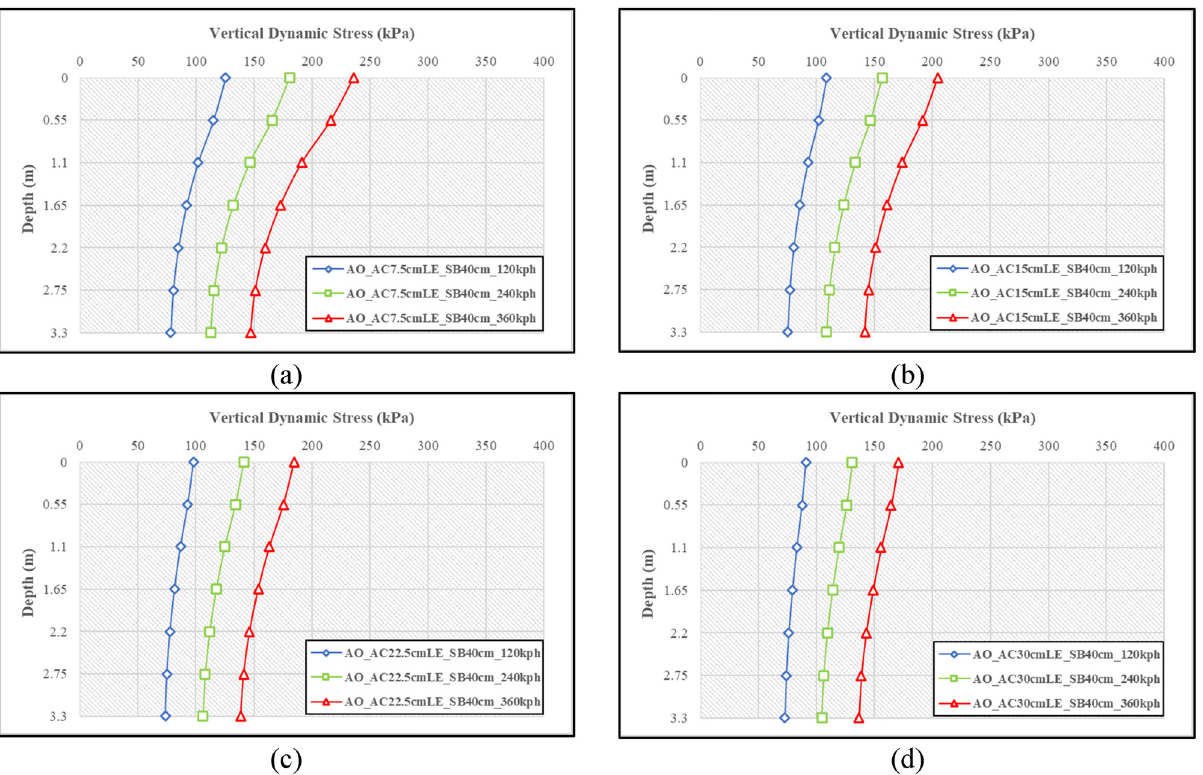
Figure 10: Vertical compressive stress curve in subgrade layer of asphaltic overlayment track under train speed of 120, 240, and 360 kph: (